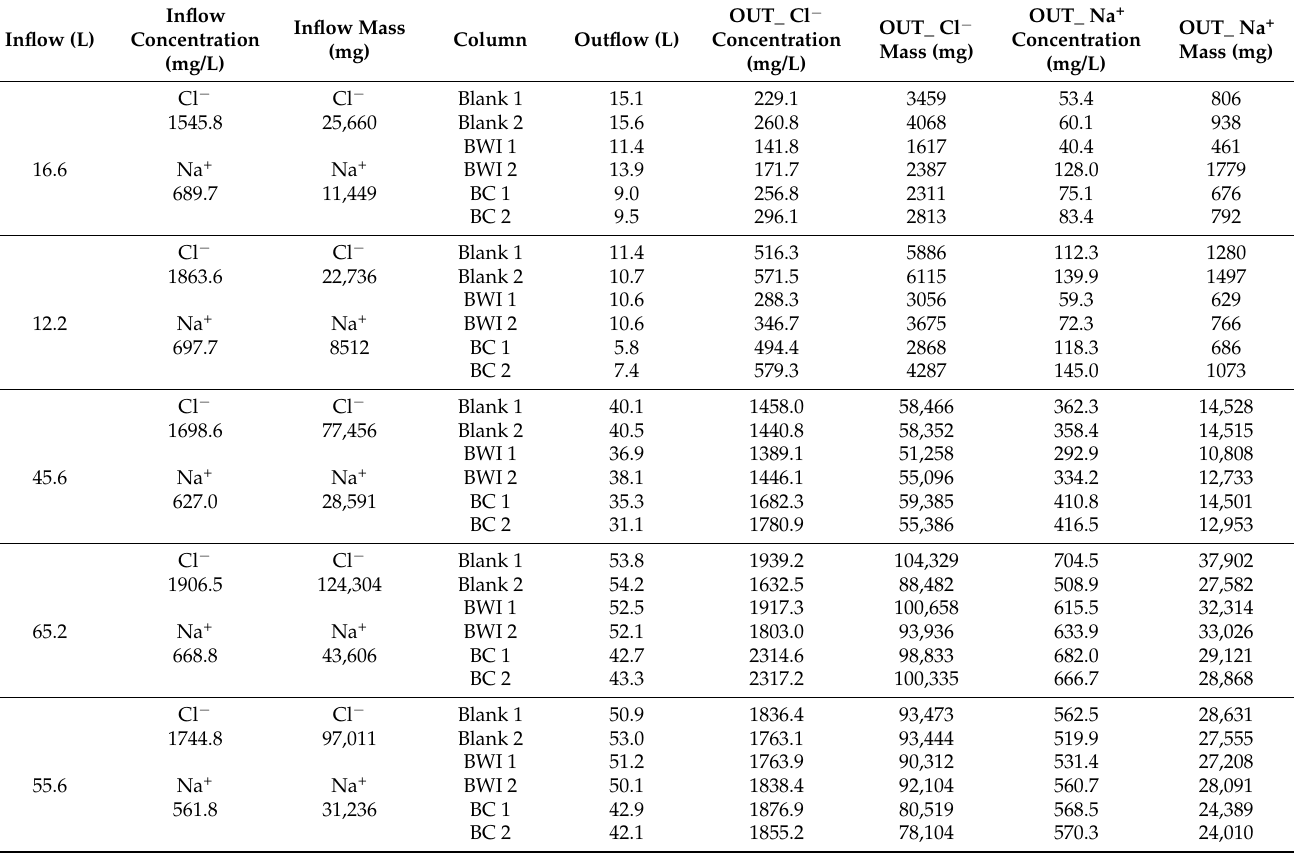
Table 6. Inflow and outflow water characteristics for high-level deicing salt concentration of synthetic stormwater runoff (Blank: no plants; BWI: Blue Wild Indigo; BC: Broadleaf